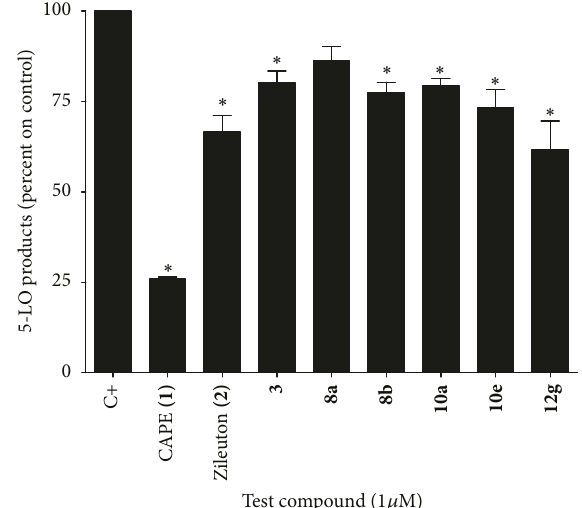
Figure 6: Inhibition of 5-LO products synthesis by analogs 8a - b , 10a , 10e , and 12g in stimulated human PMNL. Values are the means ± SEM of three independent experiments, each performed in quadruplicate; ∗ different from control (diluent) as determined by one-way ANOVA with Dunnett’s multiple comparison test ( 𝑝 < 0.05